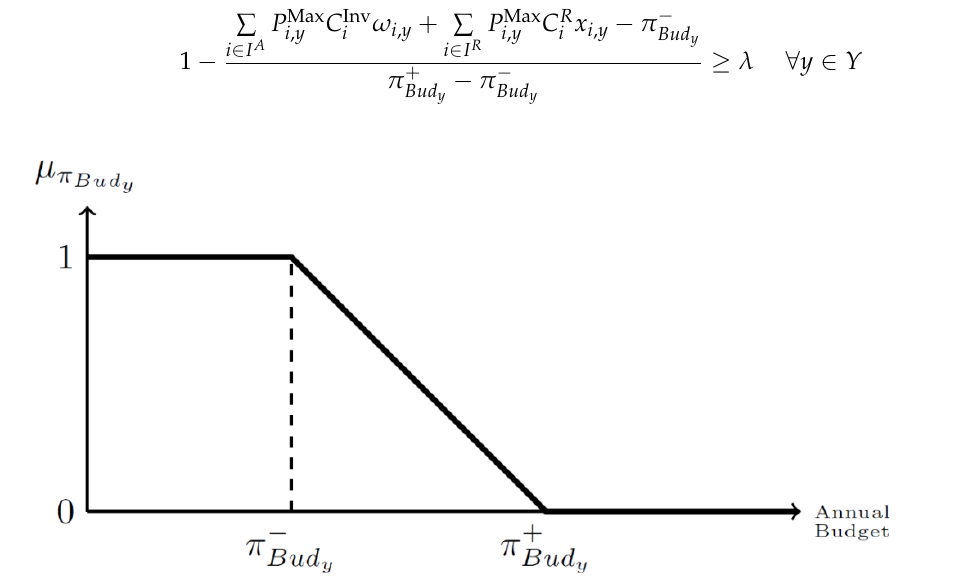
Figure 4. Fuzzy membership function for the budget constraint.